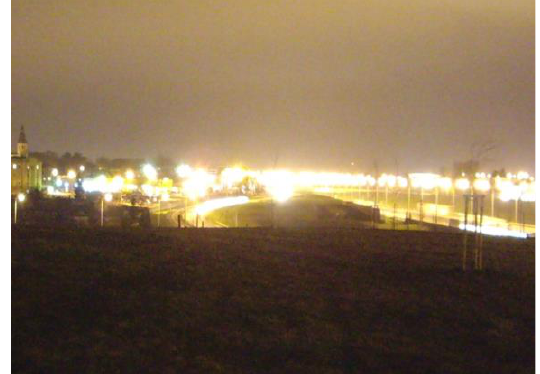
Fig. 2. View of A2 highway from Papal Hill in Lubon (yellow selection from fig. 2) [1]